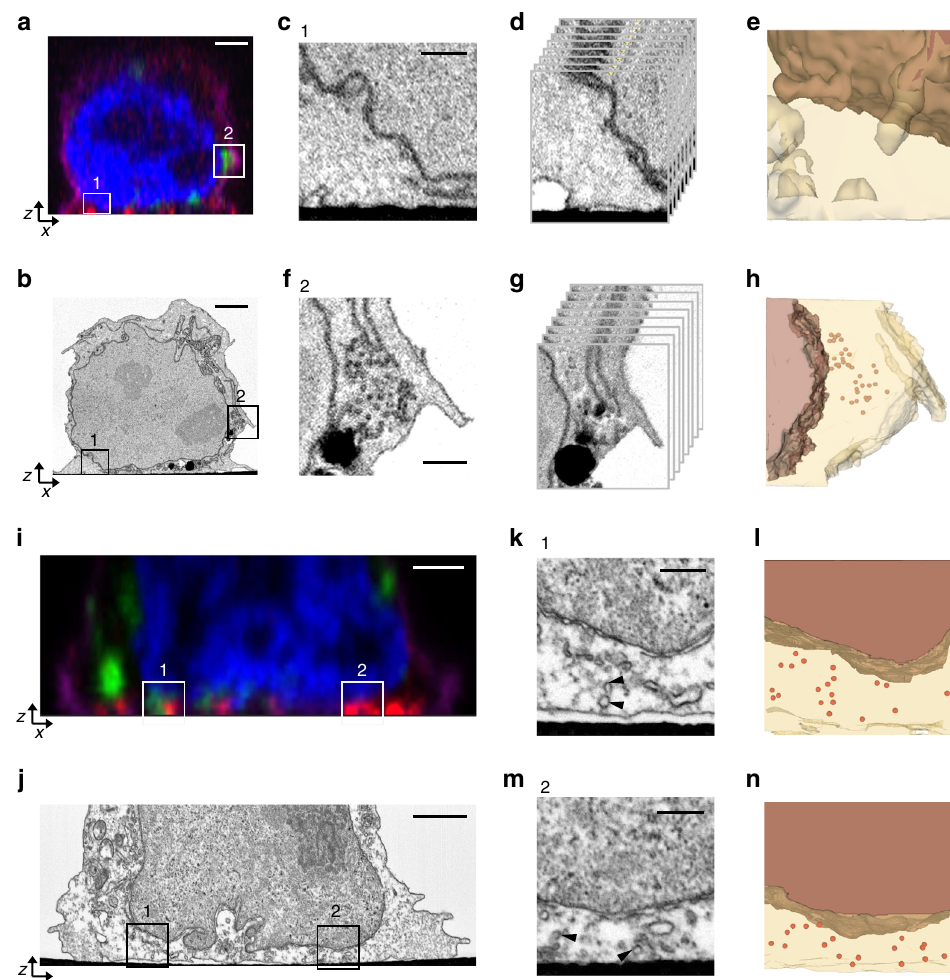
Fig. 4 Correlative 3D light and FIB-SEM of activated T cells. Jurkat cells transfected with emerald-VAMP7 (green) were dropped onto stimulatory coverslips and fi xed after 2 min a – h or 5 min i – n of activation and immunostained for pLAT (red), nucleus (blue), and plasma membrane (purple). a Images were collected of the whole cell activated for 2 min using confocal microscopy. Box 1 indicates a region with a pLAT microcluster and Box 2 indicates a region with VAMP7 vesicles. b Focused ion beam scanning electron microscopy (FIB-SEM) images were subsequently collected from the same samples. Scale bars for a and b equal 2 μ m. c , f Zoomed-in FIB-SEM image of ROI 1 and ROI 2, respectively, showing a single slice. Scale bars for c and f equal 0.5 μ m. d , g Zoomed-in FIB-SEM stacks corresponding to ROI 1 and 2, respectively. Corresponding FIB-SEM stacks are in Supplementary Movies 8 and 10, respectively. e , h Segmented FIB-SEM volumes corresponding to ROI 1 and 2, respectively; correspond to Supplementary Movies 9 and 11, respectively. i Images were collected through the whole cell activated for 5 min using confocal microscopy. Box 1 indicates a region with a pLAT microcluster in proximity of VAMP7 signal and Box 2 indicates a pLAT microcluster devoid of VAMP7 signal. j Focused ion beam scanning electron microscopy (FIB-SEM) images were subsequently collected from the same samples. Scale bars for i and j equal 2 μ m. k , m Zoomed-in FIB-SEM image of ROI 1 and 2, respectively, showing a single slice. The arrowheads indicate subsynaptic vesicles. Scale bars for k and m equal 0.5 μ m. Corresponding FIB-SEM stacks are in Supplementary Movies 12 and 13, respectively. l , n Segmented FIB-SEM volumes corresponding to ROI 1 and 2, respectively; see Supplementary Movies 14 and 15 ( n = 3 cells for 2 min; 3 cells for 5 min, two independent experiments). See also Supplementary Figure